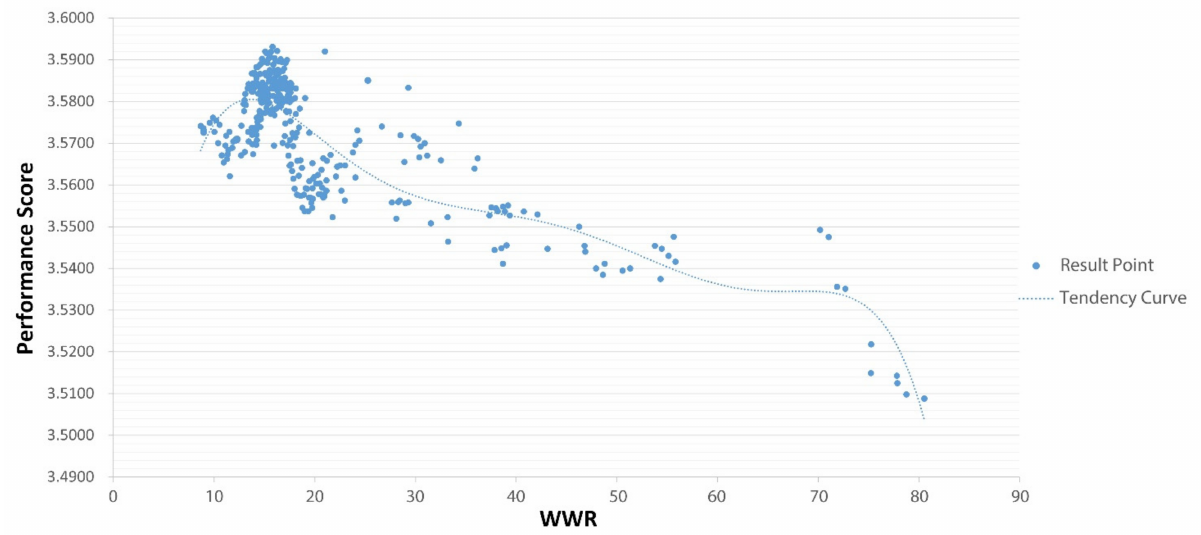
Figure 19. Relationship between WWR and optimized